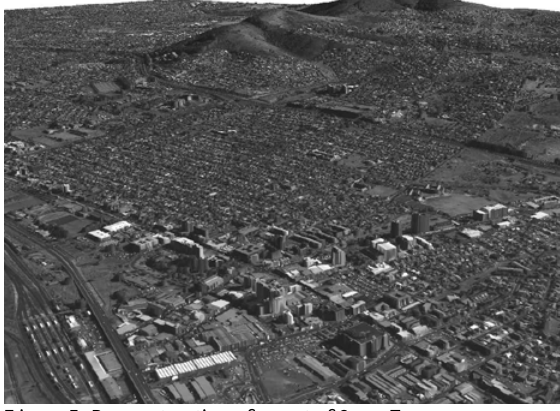
Figure 5: Reconstruction of a part of Cape